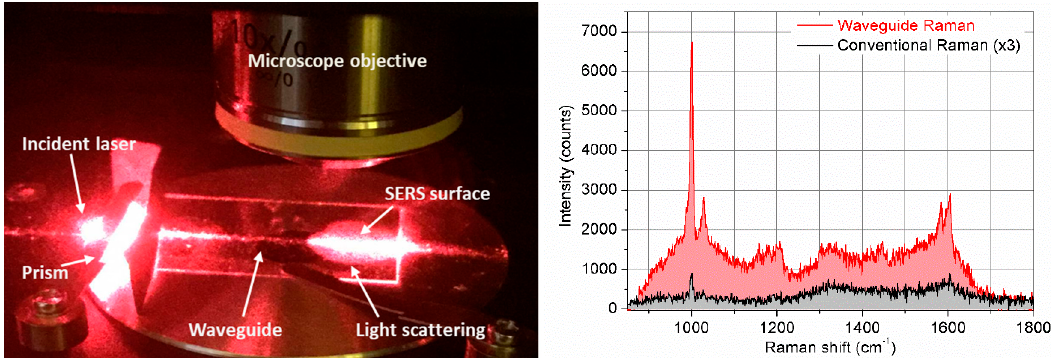
Figure 5. Left: Schematic representation of device layout: Optical set-up displaying the incident laser beam, the prism, the OWG, and the light scattering from the SERS surface (rough estimation of losses showed the value of optical losses >95%, which is in agreement with that published in literature [36], see supplementary material); Right: Raman spectra of phenylalanine taken by conventional Raman spectroscopy (in black) and by using the developed device (in red).